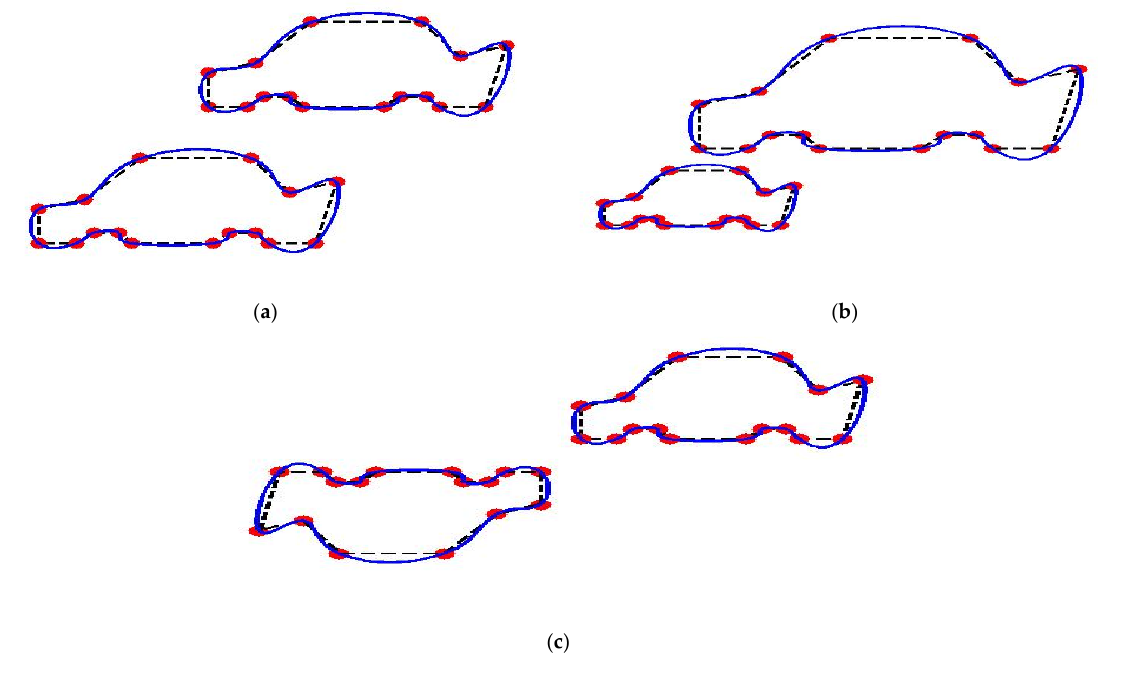
Figure 2. AI property with ( a ) translation, ( b ) rotation, and ( c ) scaling.